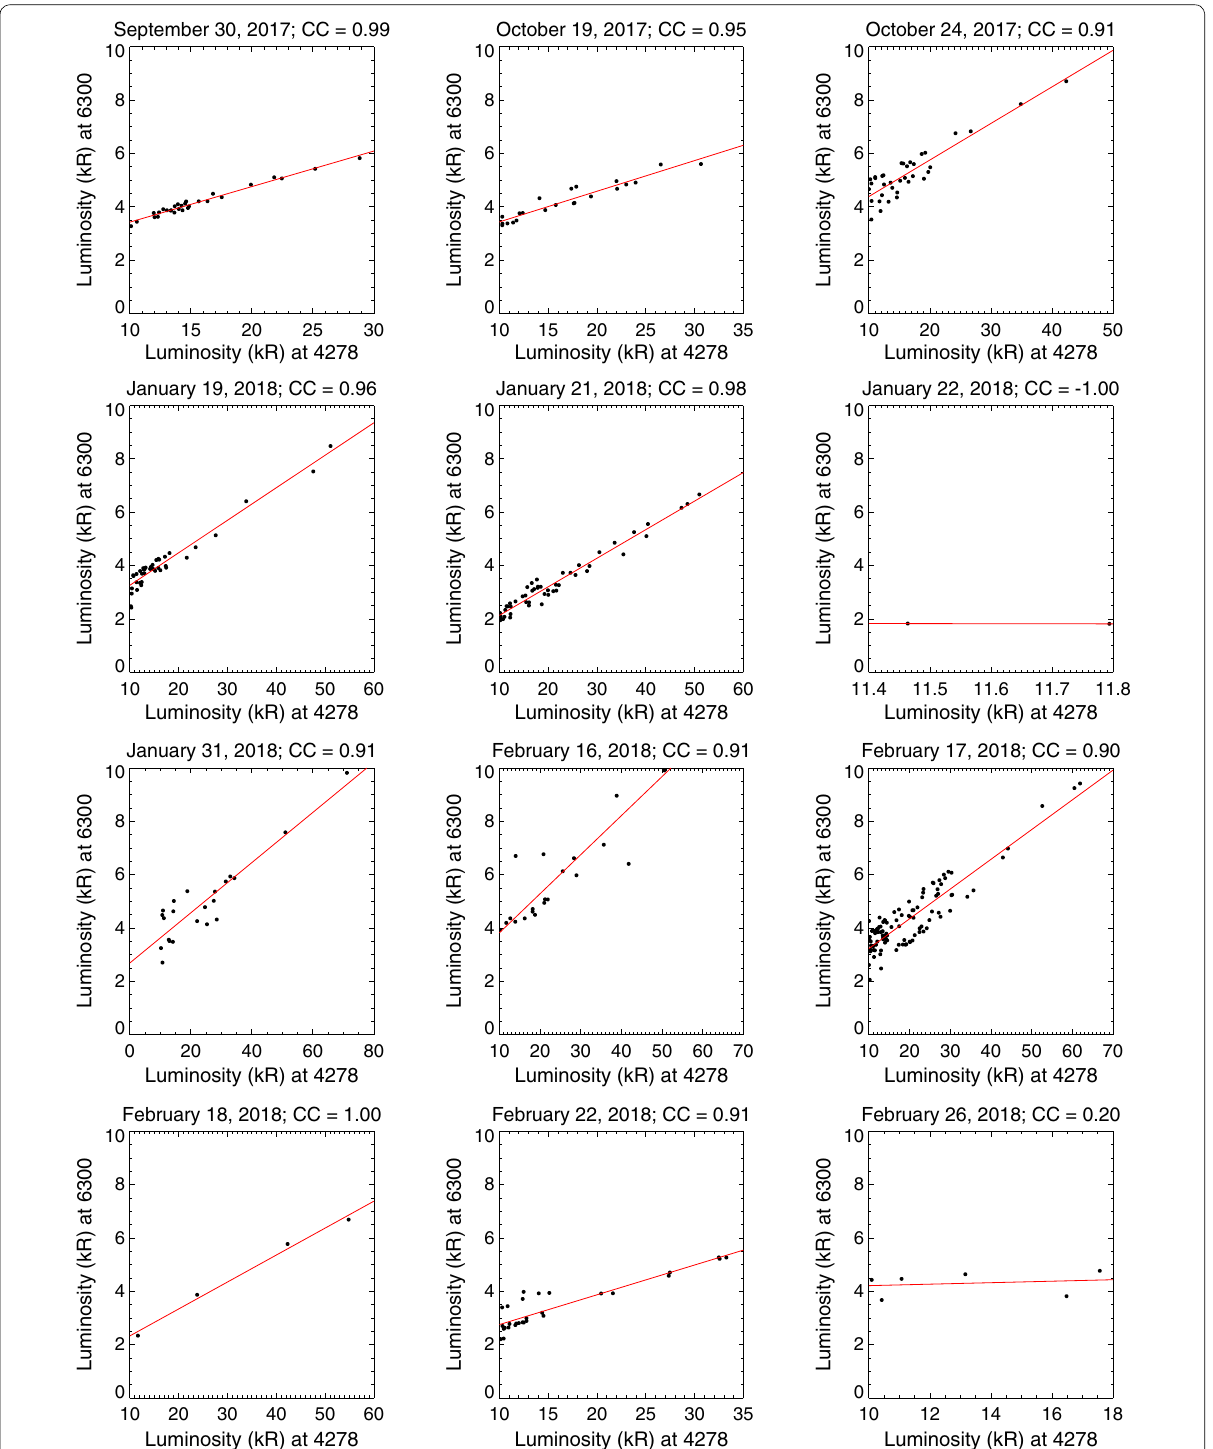
Fig. 23 Scatter plots between 427.8 nm (> 10 kR) and 630 nm emission luminosities; Scatter plots between 427.8 nm and 630 nm emission luminosities for 12 nights where the luminosity of the 427.8 nm is greater than 10